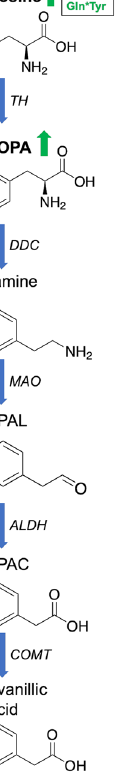
Fig. 3 Dopamine-catecholaminergic pathway. The metabolites highlighted in bold have been targeted and detected in this study. Both Tyr and L -DOPA are signi fi cantly increased in iPD patients (arrows and text in green). TH tyrosine hydroxylases, DDC dopa decarboxylase, MOA monoamine oxidase, DOPAL 3,4-dihydroxyphe- nylacetaldehyde; toxic intermediate, ALDH aldehyde dehydrogen- ase, DOPAC 3,4-dihydroxyphenylacetic acid and COMT catechol-O- methyltransferase.